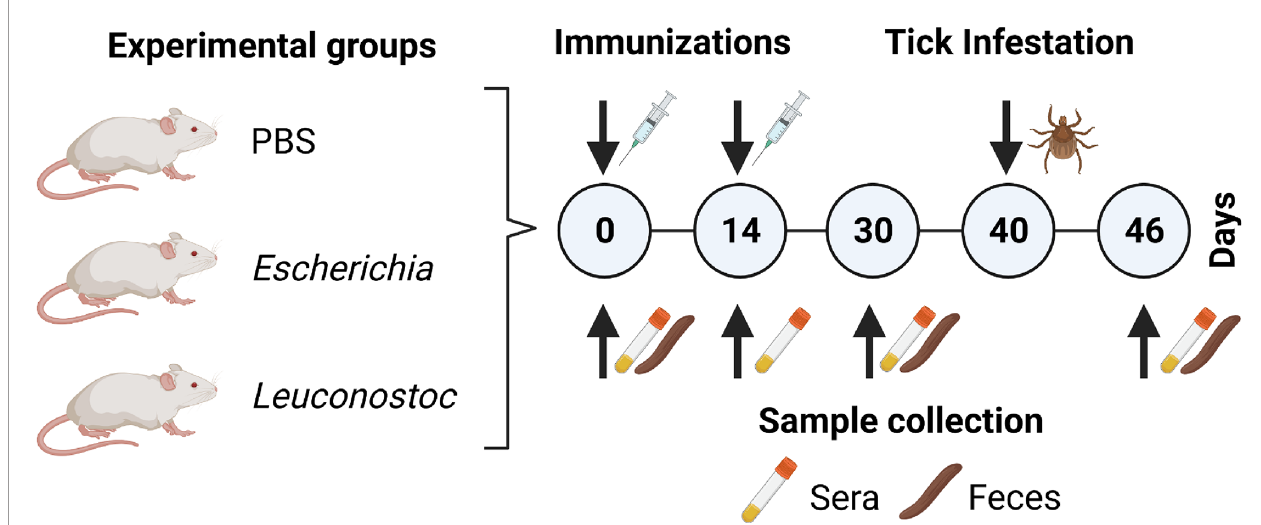
FIGURE 1 | Experimental design and sample collection. Mice were immunized twice (d0 and d14) with a live vaccine containing E. coli (n = 4) or L. mesenteroides (n = 4) or with a mock vaccine (PBS) (n = 4). At d40, animals in all groups were infested with I. ricinus nymphs (n = 20 ticks per mouse). Mice sera (used for ELISA and immuno fl uorescence) and fecal (used for mice gut microbiota analysis) samples were collected at different time points as indicated. Engorged ticks were collected and used for tick microbiota